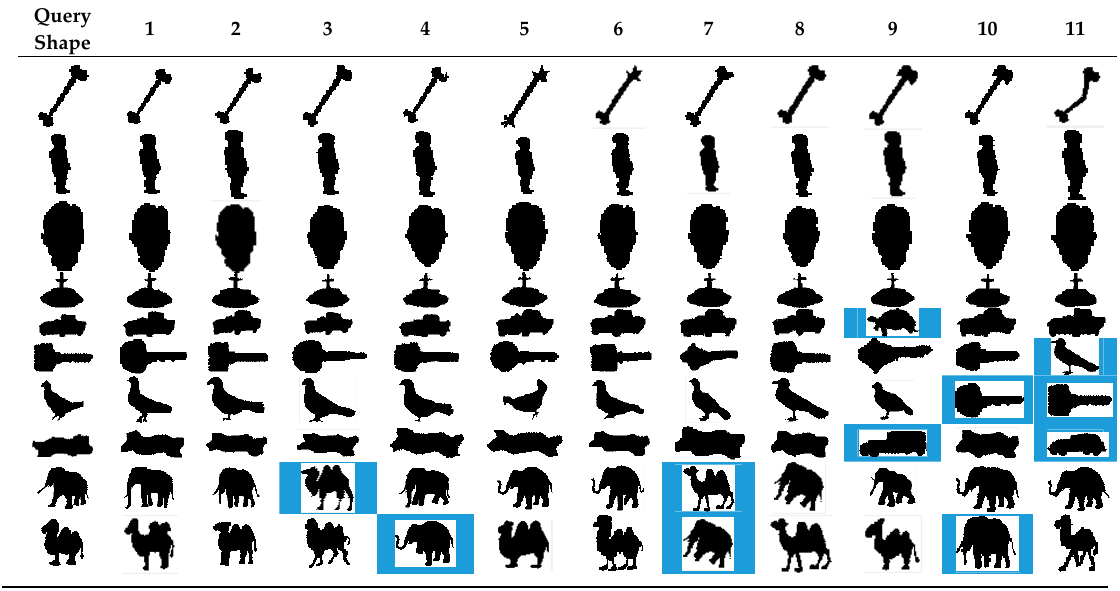
Table 1. Some query results from Kimia’s shape database.